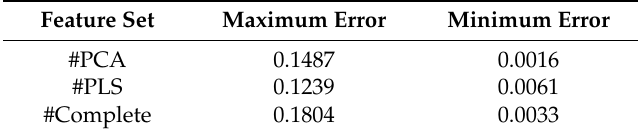
Table 8. Prediction error of different paraffin odor levels based on